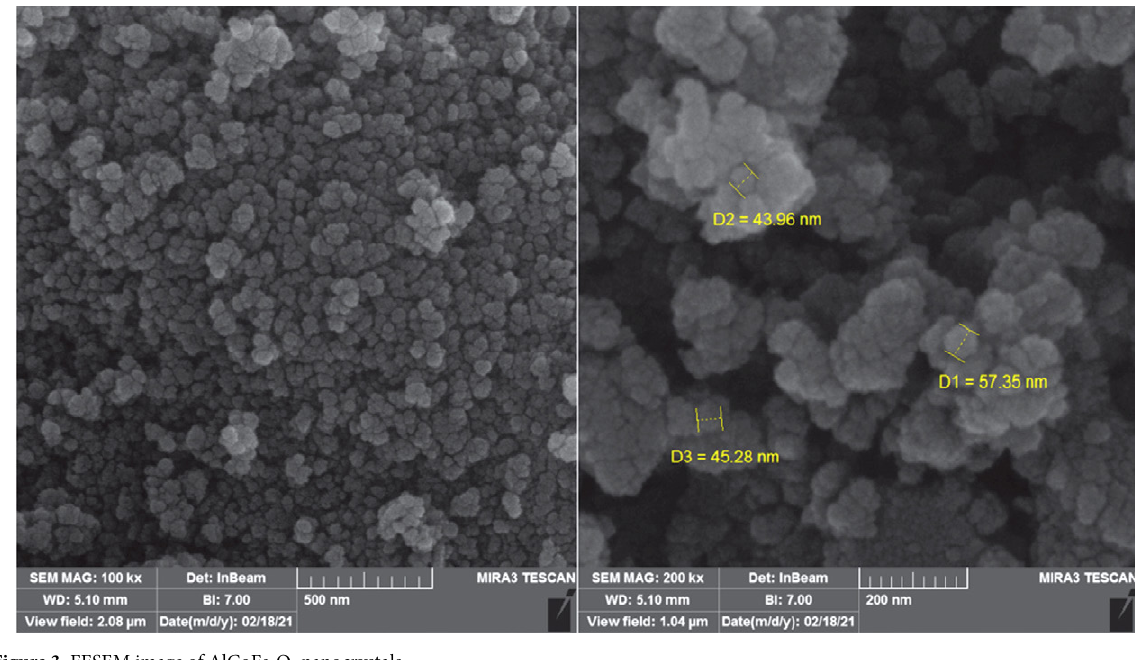
Figure 3. FESEM image of AlCoFe 2 O 4 nanocrystals